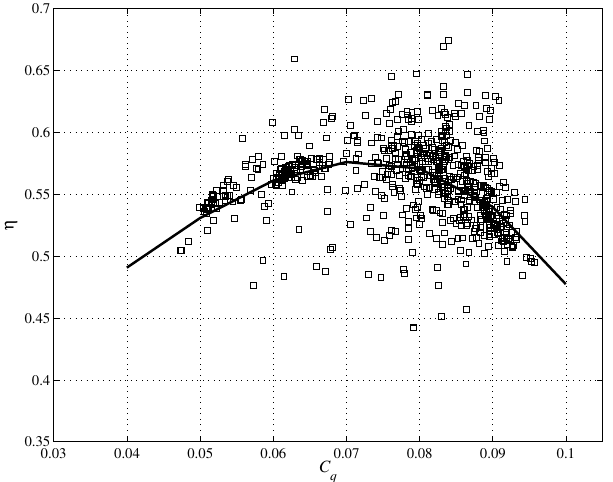
Figure 9. Fittings of data of Figs. 5 (dashed line) and 8 (continuous line) plotted on the same plane.